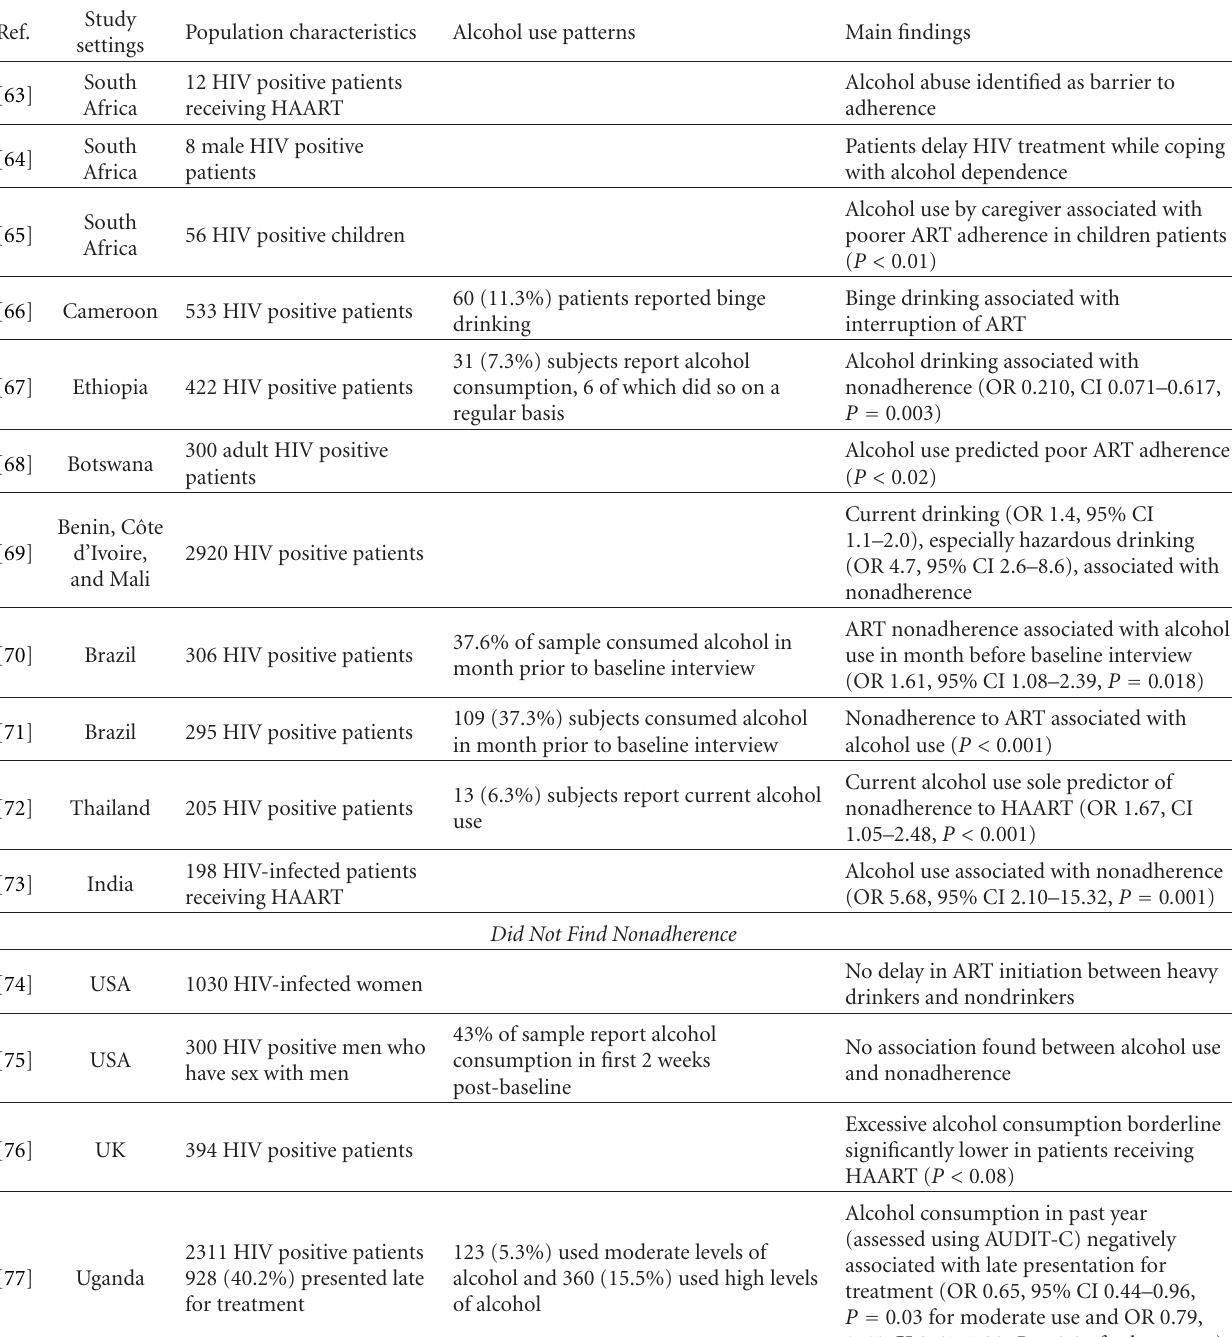
Medication Resistance. The association between ART adher- ence and the development of class-specific ART resistance represents a clinical problem. During multidrug therapy, di ff erential drug exposure increases the likelihood of devel- oping resistance. In addition, ART with higher potency